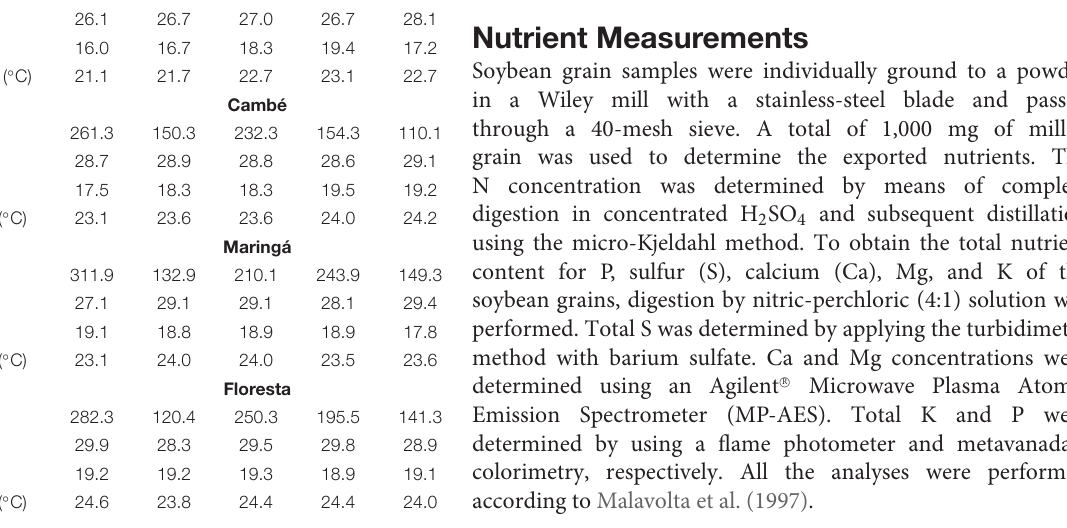
TABLE 2 | Rainfall and maximum and minimum temperatures at the four study sites during the study period. Climate characteristics